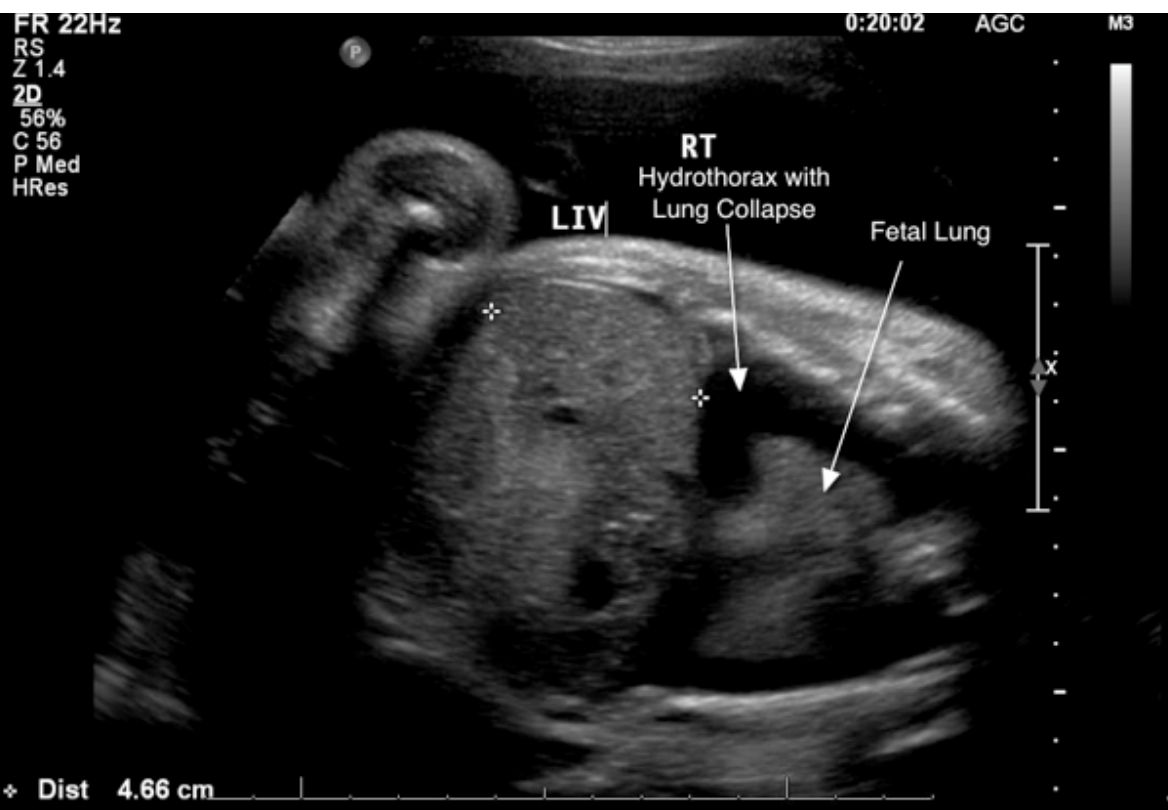
FIGURE 1. Ultrasound image at 29 weeks and 6 days gestation demonstrating fetal hydrothorax (left arrow) resulting in collapse of the fetal lungs (right arrow). The liver (LIV) is well visualized. The right side of the fetus is marked RT and the fetal head lies to the right of the ultrasound